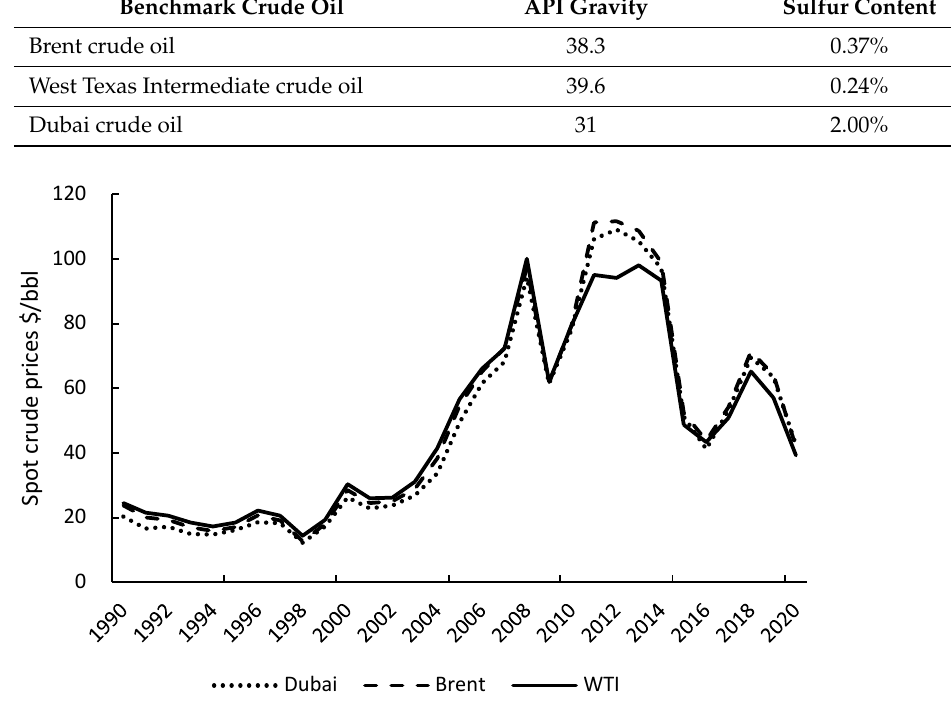
Figure 1. Spot crude prices of three benchmark crude oil: 1990–2020 (Data source: BP Statistical Review of World Energy). Table 1. The API gravity and Sulfur content of three benchmark crude oil.